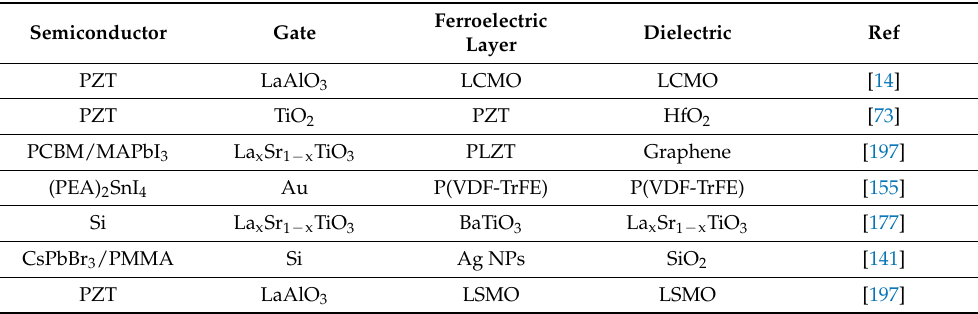
Table 8. Reported ferroelectric perovskite FETs in the literature with respective ferroelectric and dielectric layers.